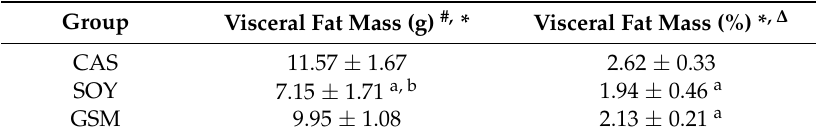
Table 4. Effect of different dietary proteins on visceral adipose tissue † .